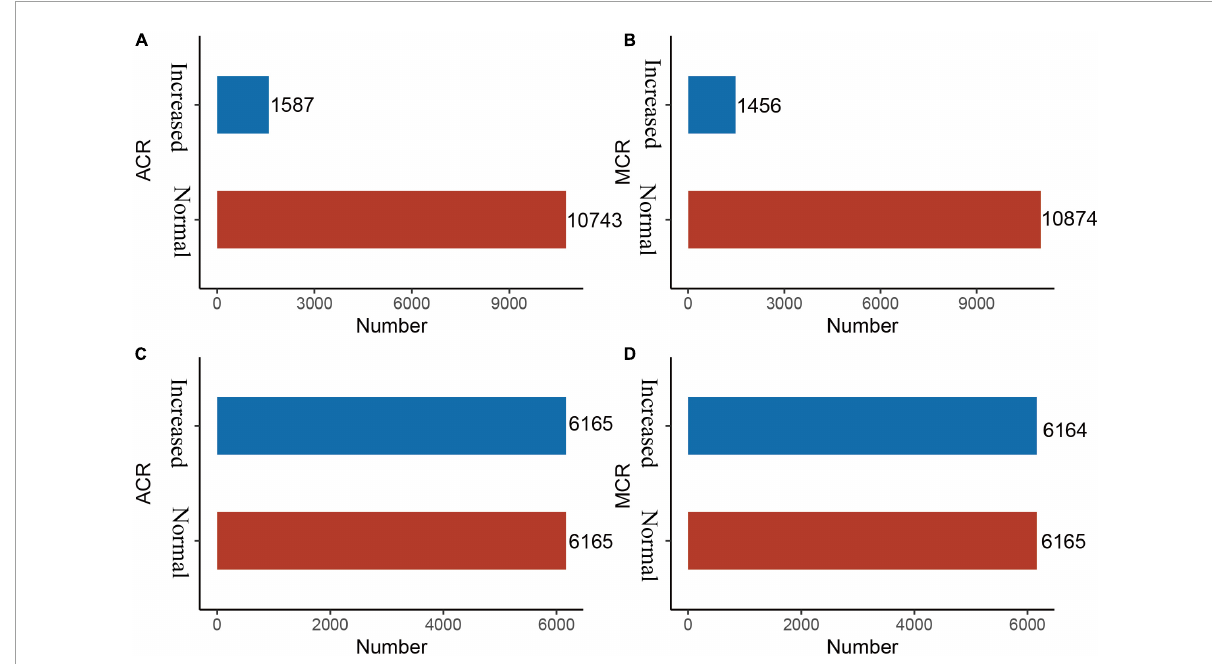
FIGURE2 Before and after SMOTE of response variables for ACR and MCR outcomes. SMOTE, Synthetic Minority Over-Sampling Technique. It’s a good and powerful way to handle imbalanced data, and it was conducted under the parameters of k = 5, C.perc = “balance”, dist = “Overlap”. (A) ACR outcomes (before SMOTE); (B) MCR outcomes (before SMOTE); (C) ACR outcomes (after SMOTE); and (D) MCR outcomes (after